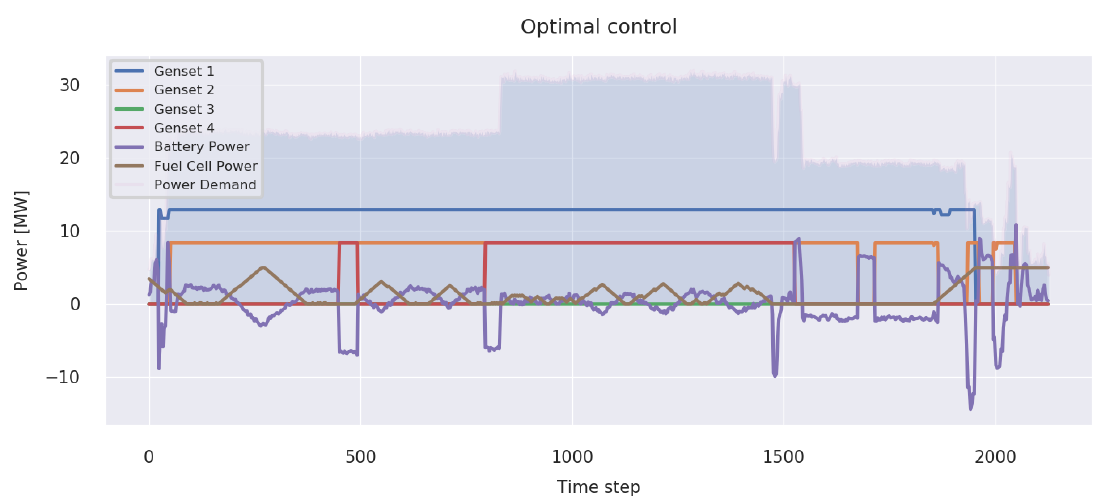
Figure 7. Mediterranean trip unit commitment with fully optimized